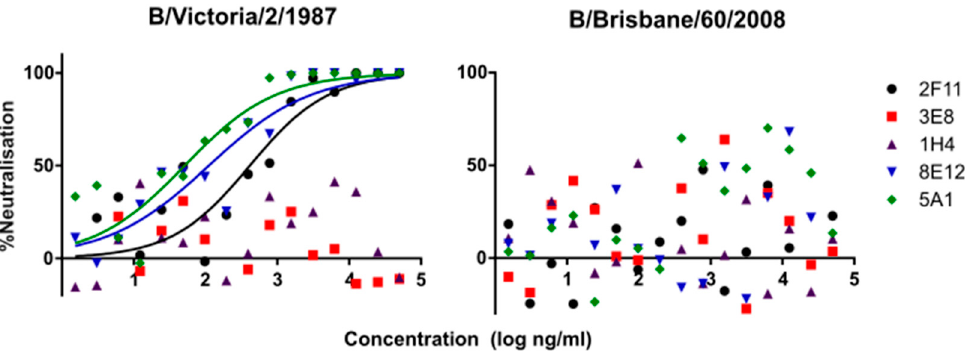
Figure 3. pMN neutralisation curves for FDA mAbs 2F11, 3E8, 1H4, 8E12 and 5A1 against PV bearing HA glycoproteins from Victoria lineage strains B/Victoria/2/1987 and B/Brisbane/60/2008. Victoria lineage PVs are not neutralised by Yamagata-specific mAbs 3E8 or 1H4. A/Victoria/2/1987 PV is neutralised by Victoria lineage-specific mAbs 5A1, 8E12 and cross-lineage mAb 2F11. B/Brisbane/60/2008 PV are not neutralised by any of the mAbs tested, including Victoria lineage and cross-lineage mAbs with a high degree of assay variability.